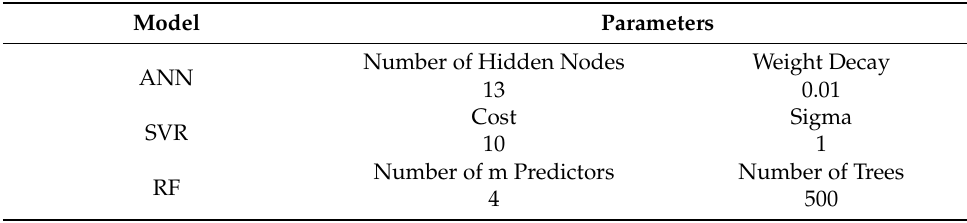
Table 4. Summary of optimal parameters for each machine learning model.